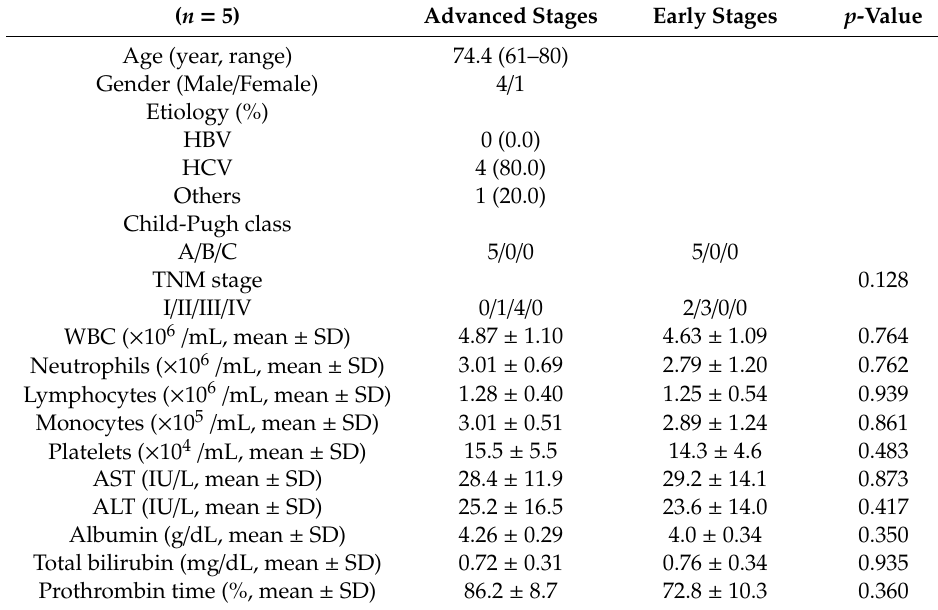
Table 2. Changes in the clinical characteristics of same patients following tumor regression. ( n =